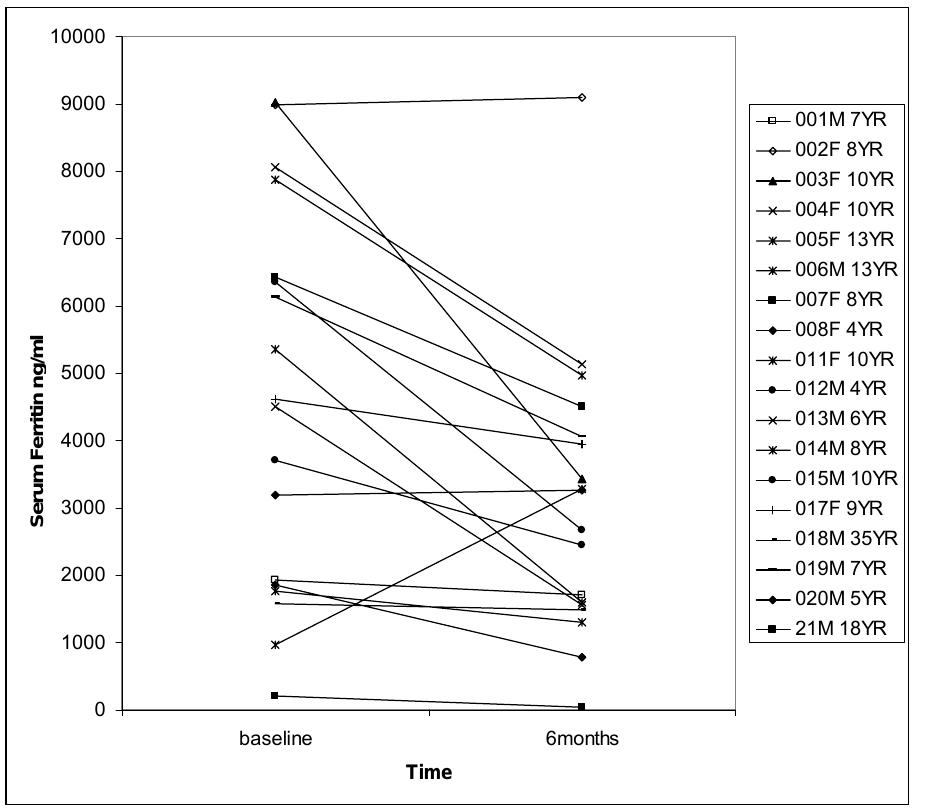
FIGURE 8. Decrease in serum ferritin at 6 months postinfusion of the RSC when compared to baseline. Each line style on the right denotes patient, sex, and age. No chelation therapy was given following infusion of the RSC.